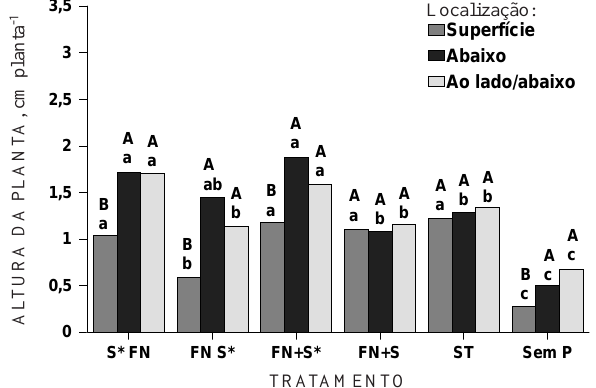
Figura 2. Altura das plantas nos tratamentos FN revestindo o enxofre inoculado com Acidithiobacillus (FN S*), FN revestido com S inoculado com Acidithiobacillus (S* FN), mistura FN com S inoculado com Acidithiobacillus (FN + S*), mistura FN com S sem Acidithiobacillus (FN + S), superfosfato triplo (ST) e sem adição de fósforo (sem P) de acordo com a localização do adubo. Letras minúsculas comparam as médias dos diferentes tratamentos com adição de P em cada modo de localização do adubo; as maiúsculas, cada tratamento com P nos diferentes modos de localização do adubo. C.V. % =